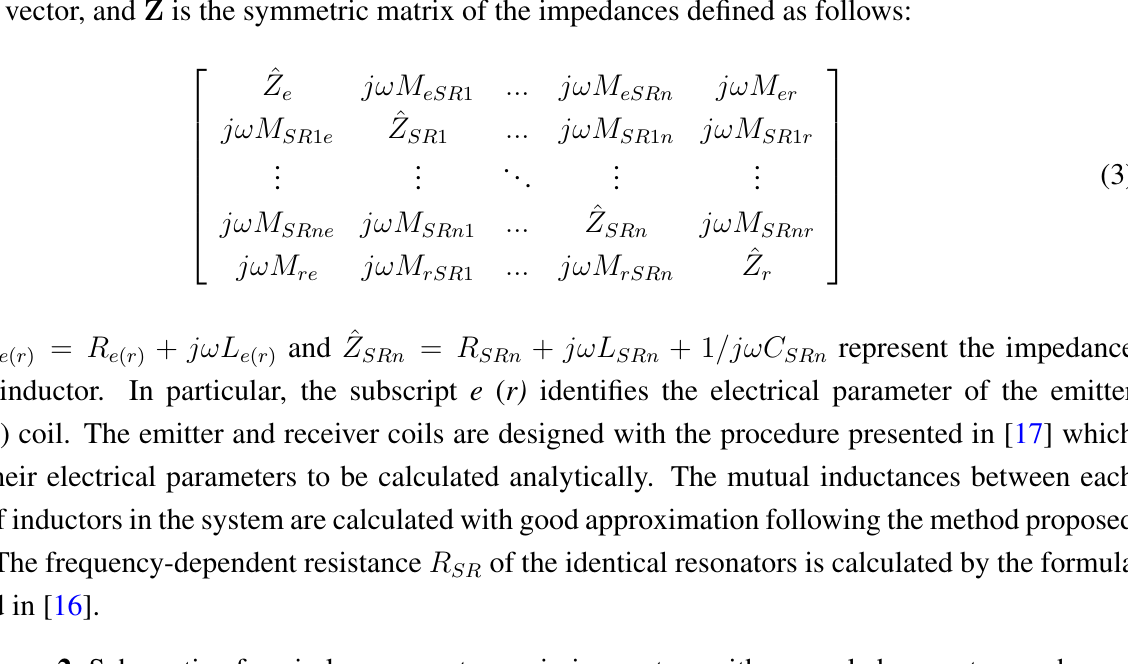
Figure 2. Schematic of a wireless power transmission system with n coupled resonators and its equivalent electric